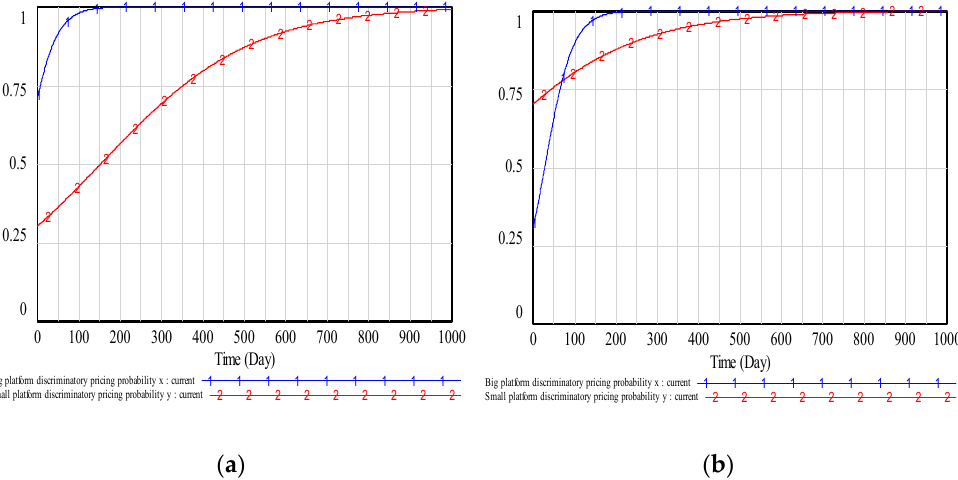
Figure 5. The dynamic evolution paths of case ④ . ( a ) The initial proportion pair of both types of platforms is (0.7,0.3) . ( b ) The initial proportion pair of both types of platforms is (0.3,0.7) .